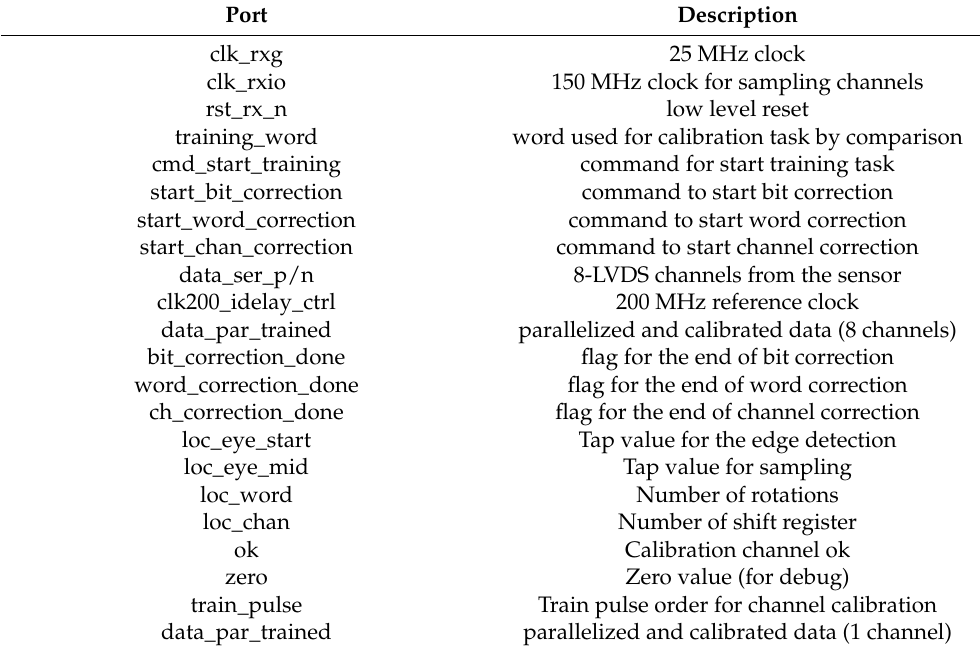
Table 1. Port description of training_one_channel.v